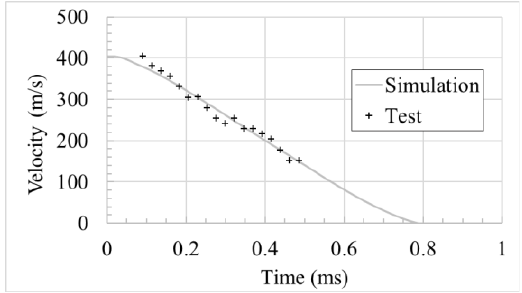
Fig. 3. Projectile deceleration during